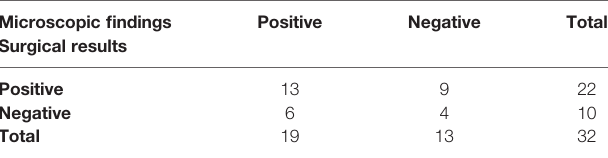
TABLE 3 | Frequency of true positive, false positive, true negative, and false negative of